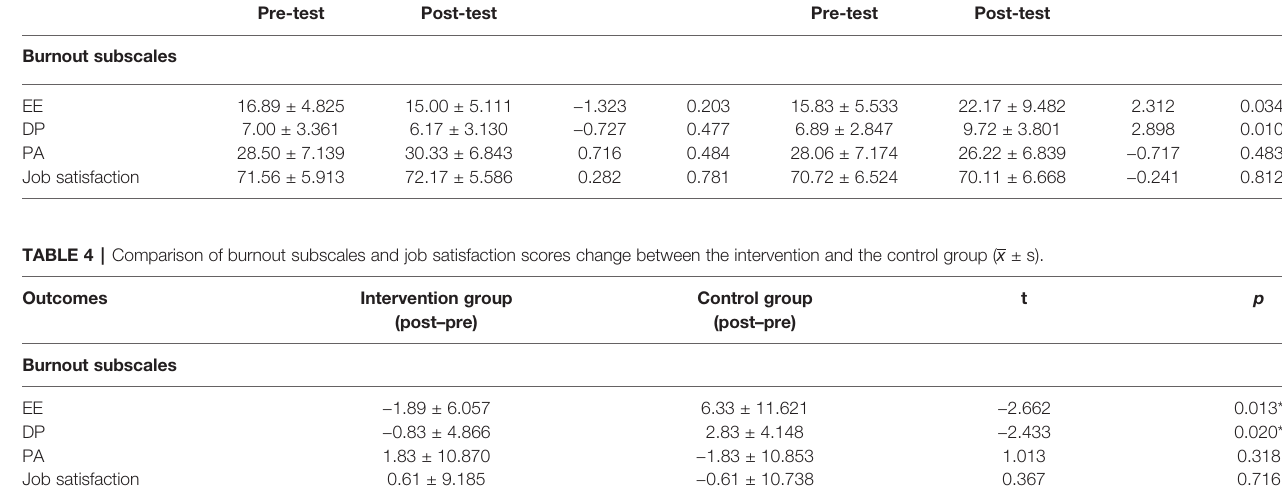
TABLE 3 | Comparison of burnout subscales and job satisfaction scores between pre- and post-Balint intervention of the two groups respectively ( x ± s).